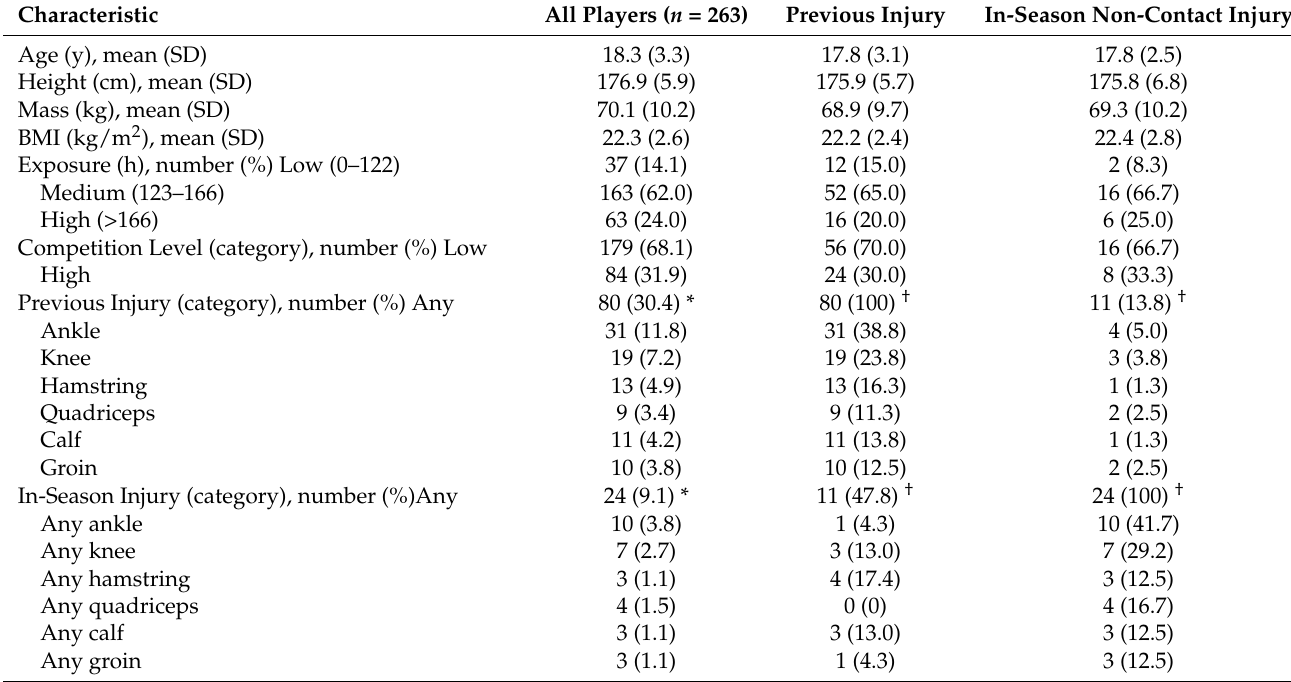
Table 1. Characteristics of male amateur football players included in the study ( n = 263), those with a previous lower limb injury ( n = 80), and those with a non-contact in-season lower limb injury ( n = 24).